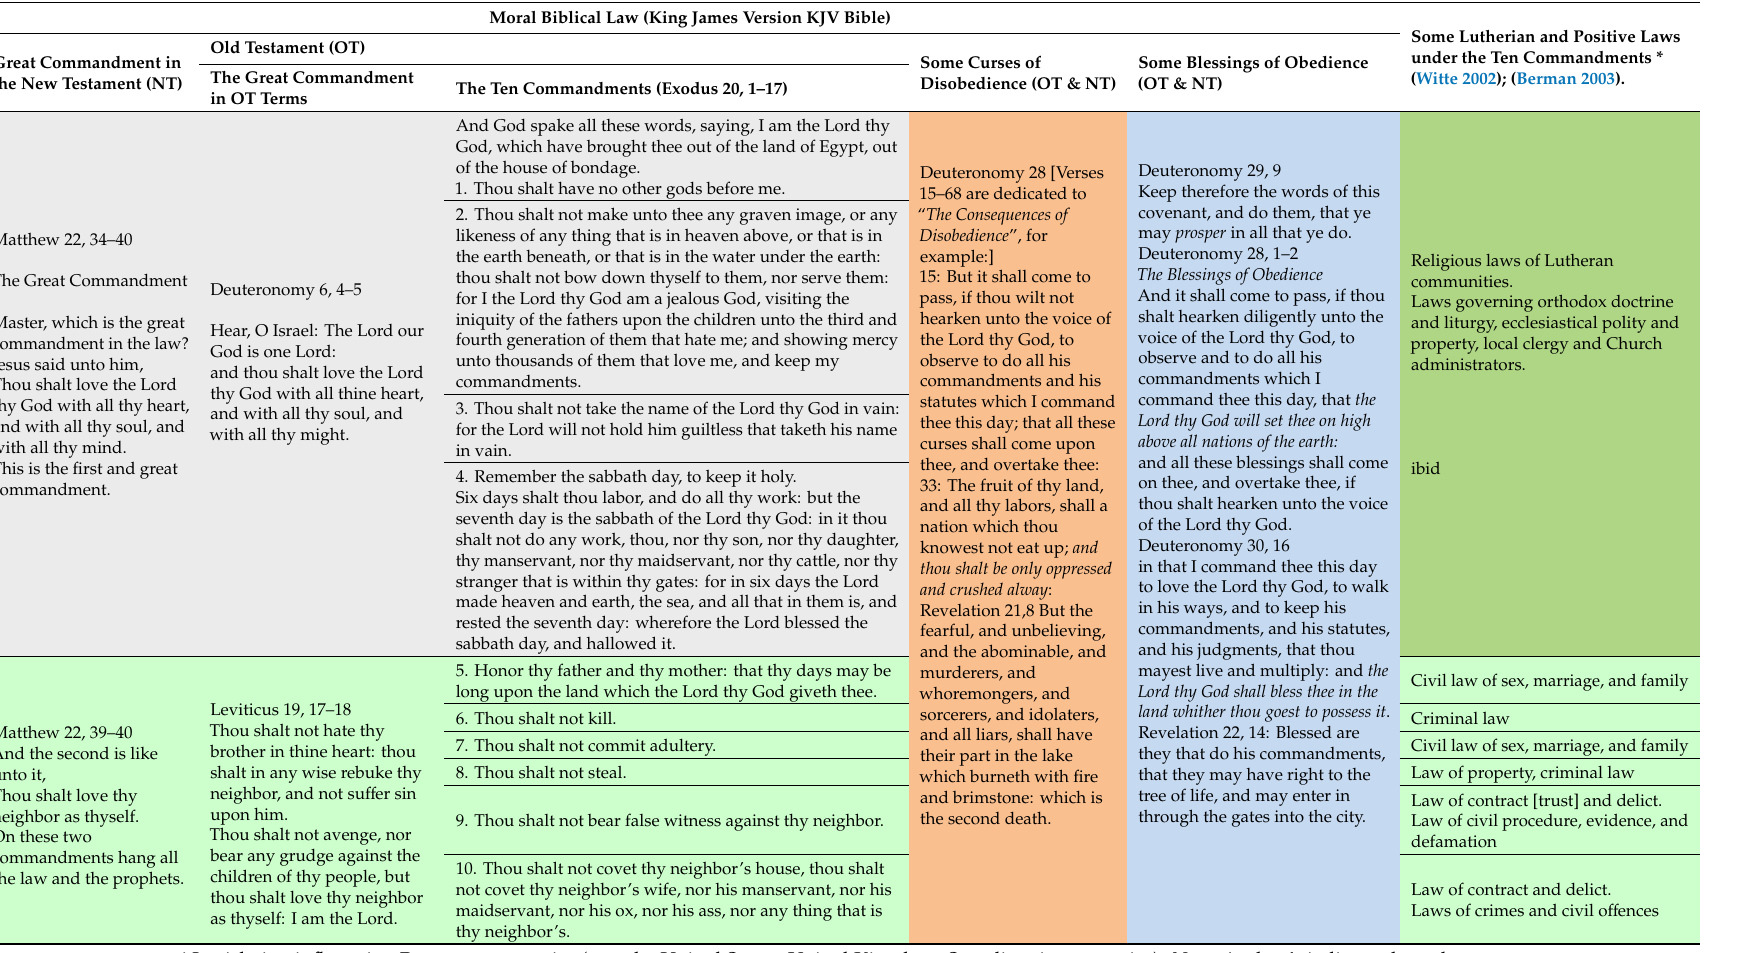
Table 5. Moral biblical law (associated with prosperity when obeyed or with misfortunes when disobeyed) and its legal application in Protestant countries (adapted from The Holy Bible, King James Version; Witte 2002; Berman